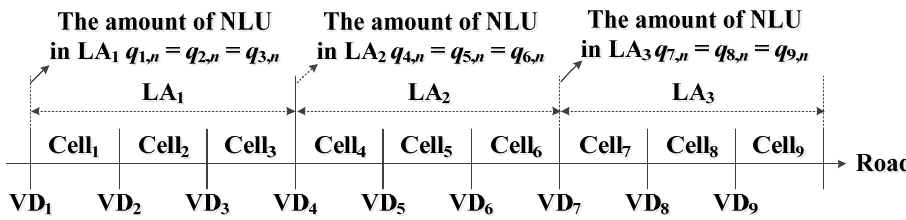
Figure 7. The distribution of cells, location areas and vehicle detectors (VDs) in the simulation experiments.